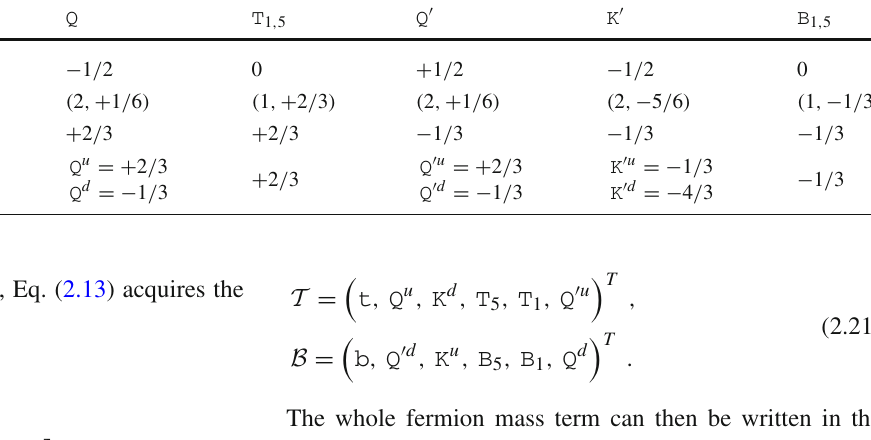
Table 2 Decompositions of the exotic quarks and their transformations under the SM group